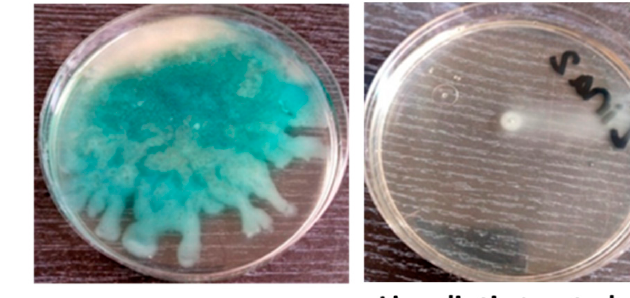
Figure 3. Linagliptin diminishes the P. aeruginosa motility. The swarming zones of P. aeruginosa on agar plates provided with or without linagliptin at sub-MIC were measured. Linagliptin significantly diminished bacterial motility, *** = p ≤ 0.0001.